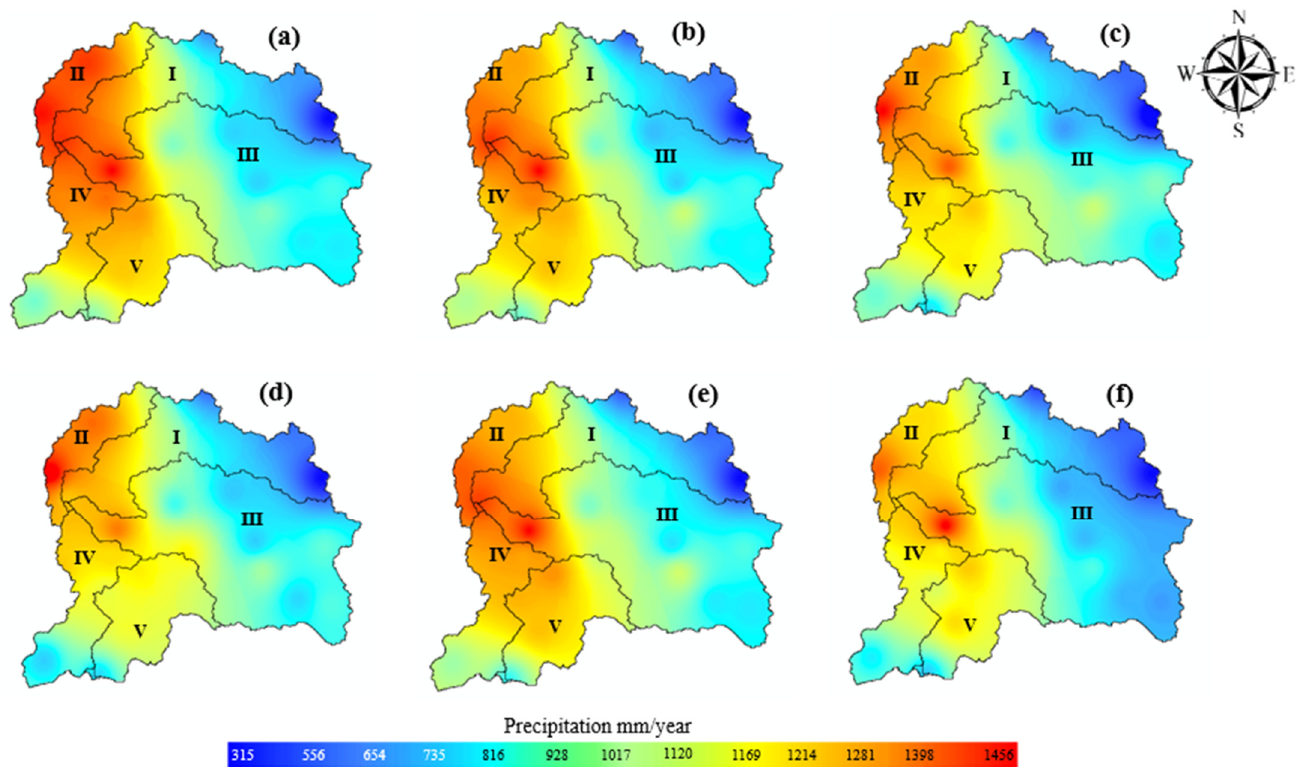
Figure 2. Spatial variability of average annual precipitation over JRB during the entire study period 1981–2009 from ( a ) in-situ gauges, ( b ) MSWEP, ( c ) ERA-5, ( d ) APHRO, ( e ) PGMFD, and ( f ) CHIRPS. Whereas I, II, III, IV and V represent Neelum, Kunhar, Jhelum, Kanshi and Poonch sub-basins, respectively.